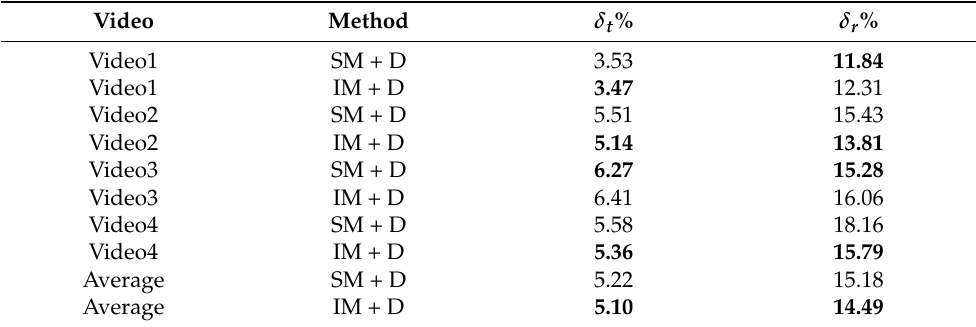
Table 6. The detection errors. “SM + D” and “IM + D” are the same as in Table 2. No ID switching occurs for the 10 selected particles in each video.